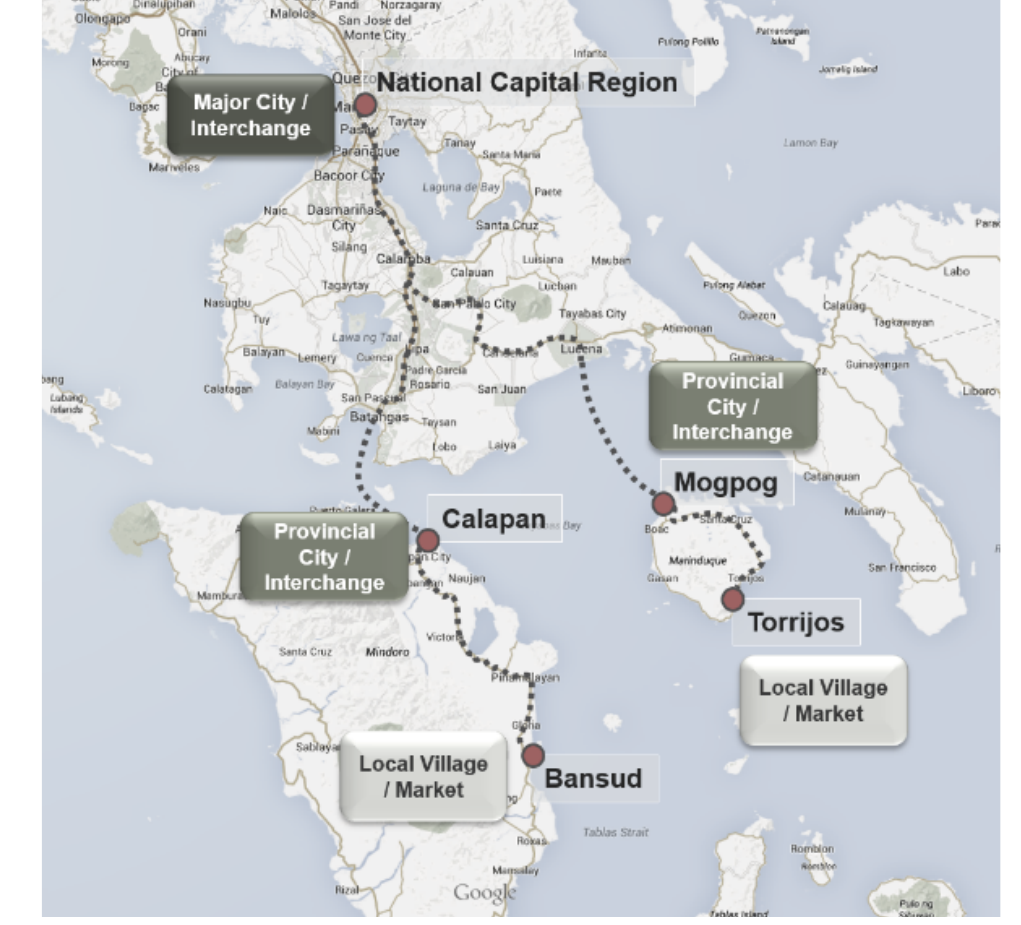
Figure 4. Survey area selection schema based on a hierarchy of cities and towns.